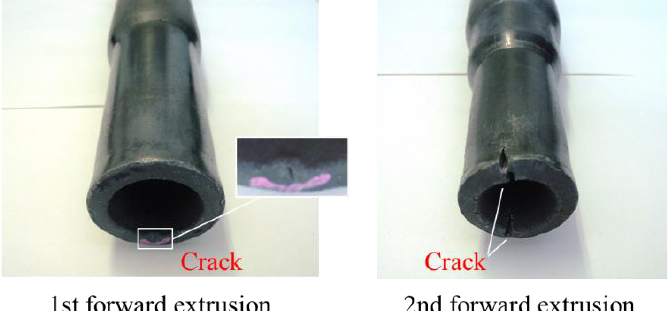
Figure 15. Ductile fracture of hollow shaft parts.